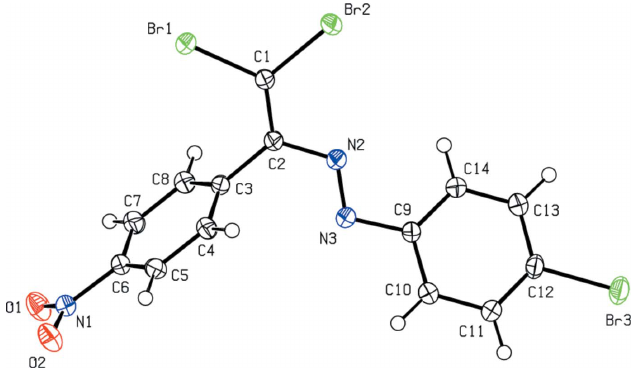
Figure 1 The molecular structure of the title compound. Displacement ellipsoids are drawn at the 50% probability